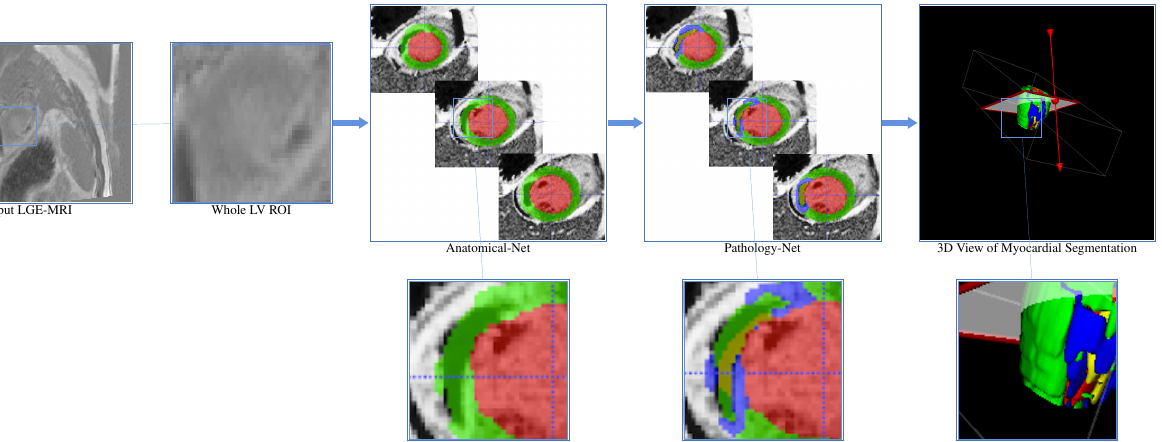
Figure 2. Workflow of our ICPIU-Net approach for fully automatic myocardial disease segmenta- tion. The red, green, blue, and yellow colors show the LV cavity, the LV myocardium, scar, and MVO, respectively.